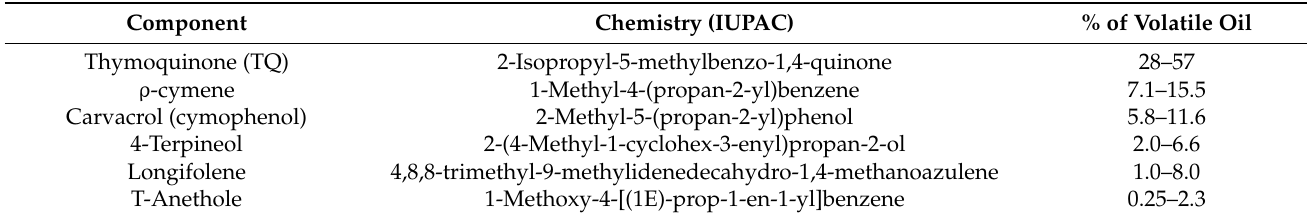
Table 1. Constituents of the Volatile Oil of Black